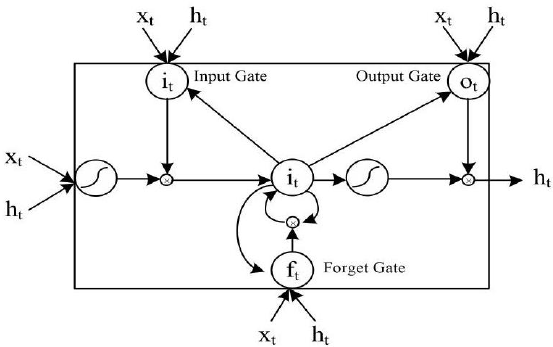
Figure 2. Internal structure of LSTM.